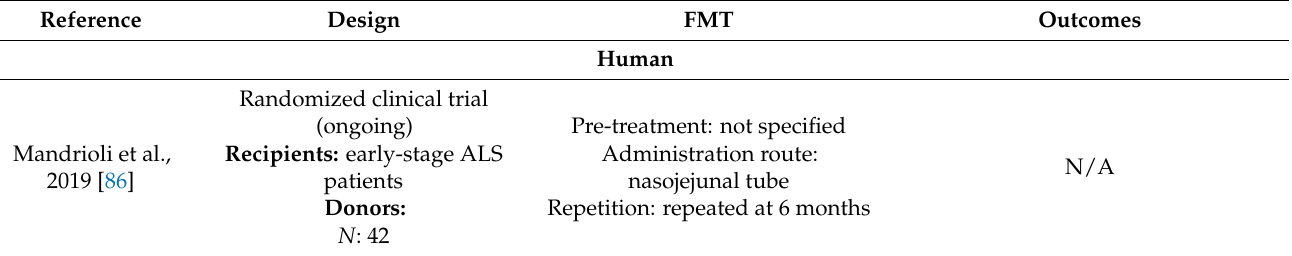
Table 4. ALS research involving